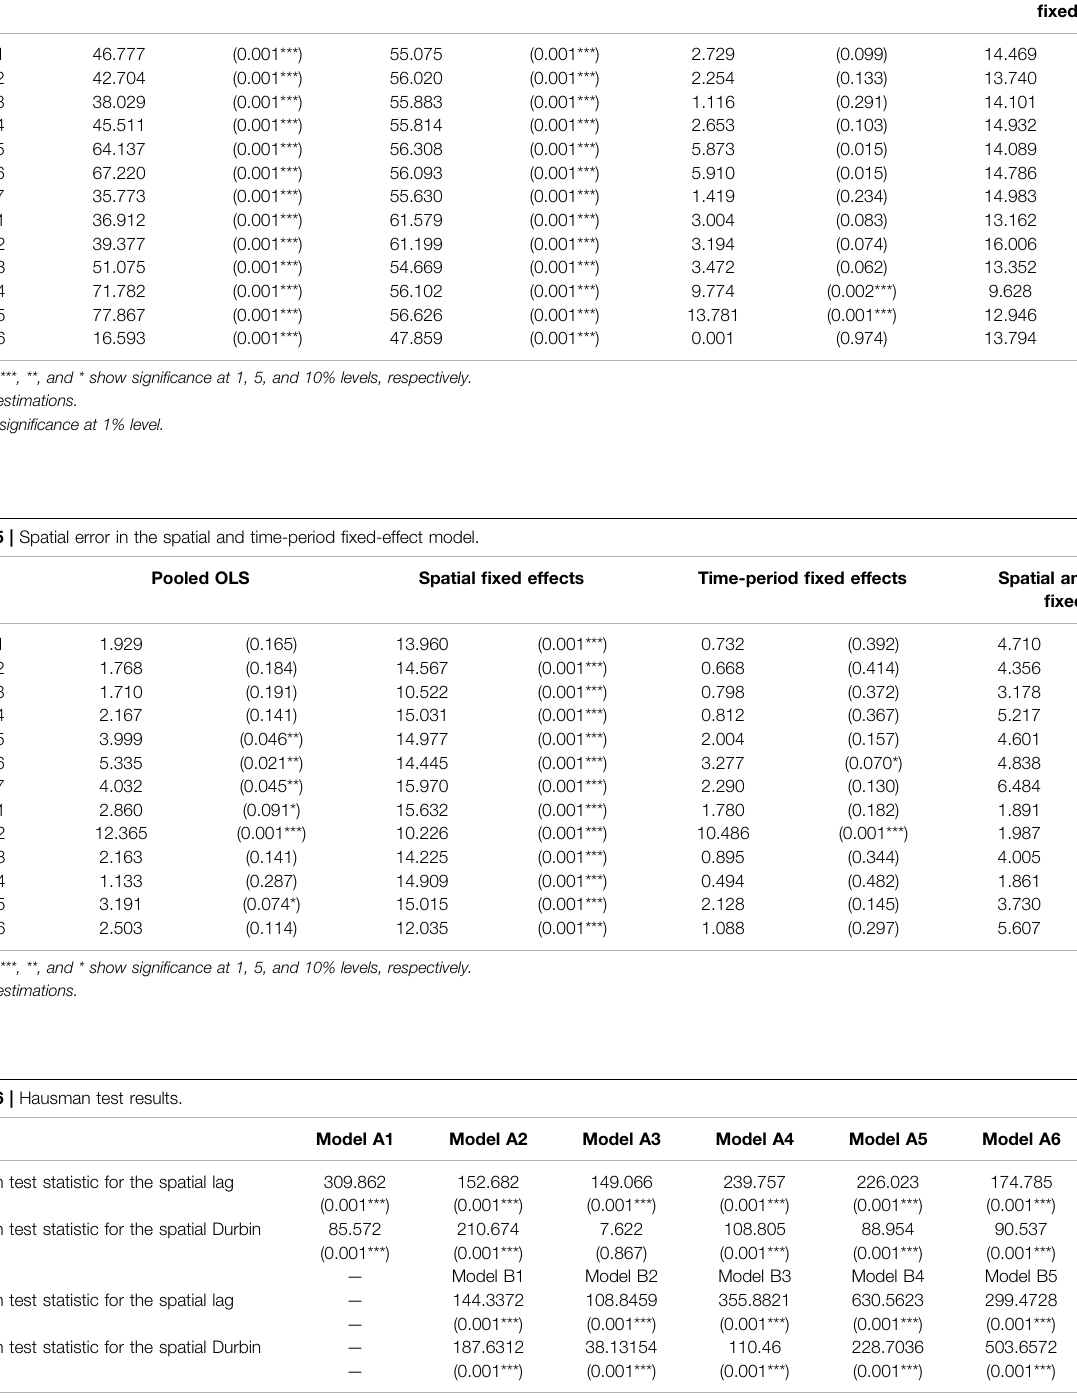
TABLE 4 | The spatial lag in the spatial and time-period fi xed-effect model. Pooled OLS